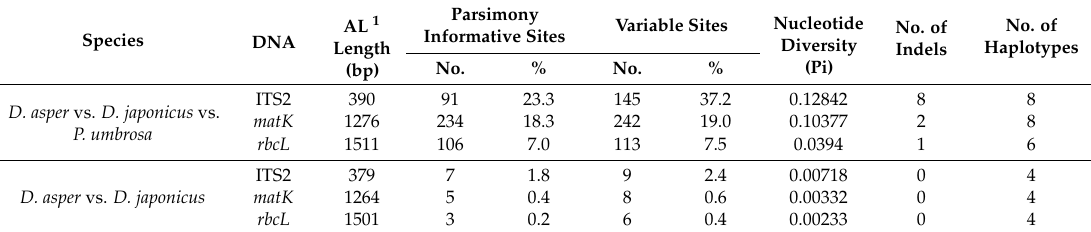
Table 1. The analysis of universal DNA barcodes in Dipsacus asper , D. japonicus , and P. umbrosa . Species DNA